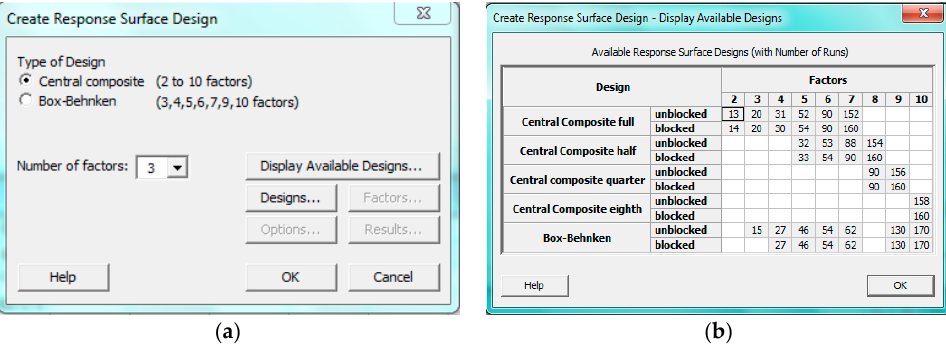
Figure 4. ( a ) Type of design. ( b ) Available design in the response surface design method. Table 4. L-9 Array for the design of the experiments.